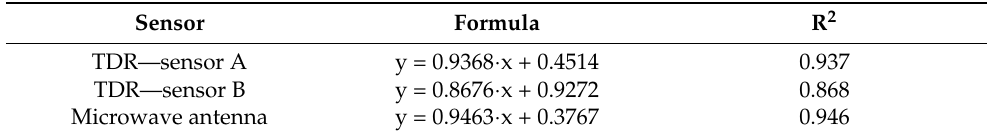
Figure 10. Dependences between material moisture evaluated gravimetrically and using various electric sensors. Red dots denote measuring points. Table 3. Relations between gravimetric water content measured gravimetrically and evaluated by indirect techniques.